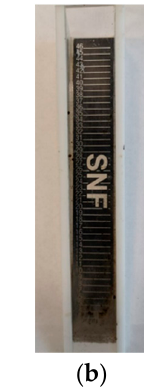
Figure 4. ( a ) Torque profiles of the flocculation on A3338-treated FFT-4 with different dosages; ( b ) The net water release (NWR) results corresponding to the torque profiles of the